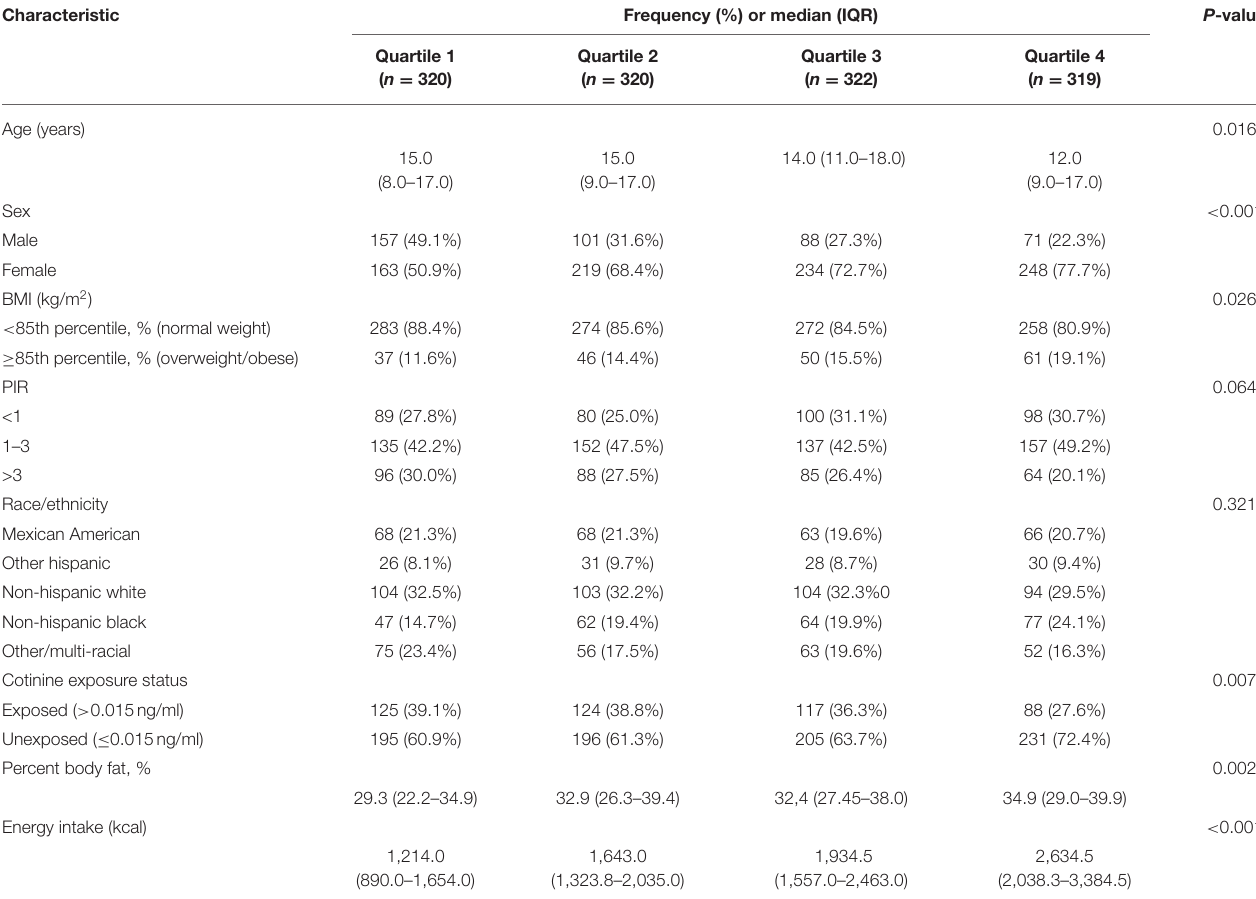
TABLE 1 | Distribution of characteristics across quartiles of C-DII in national health and nutrition examination surveys, United States, 2015-2018.